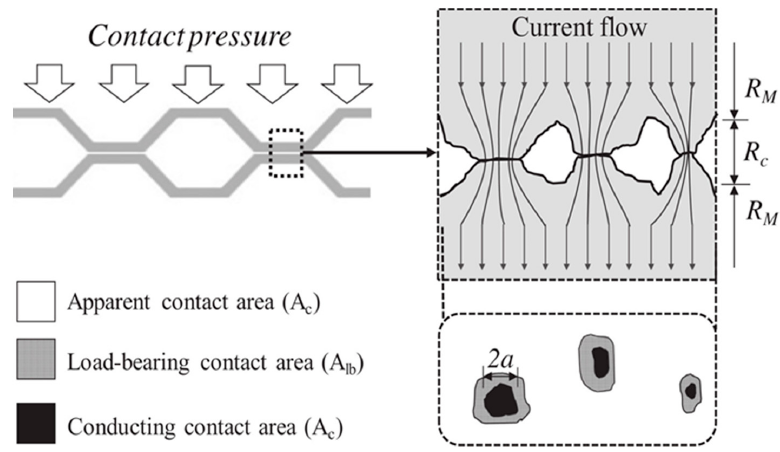
Figure 1. Electrical surface contact model with asperities and conducting contact area [8].